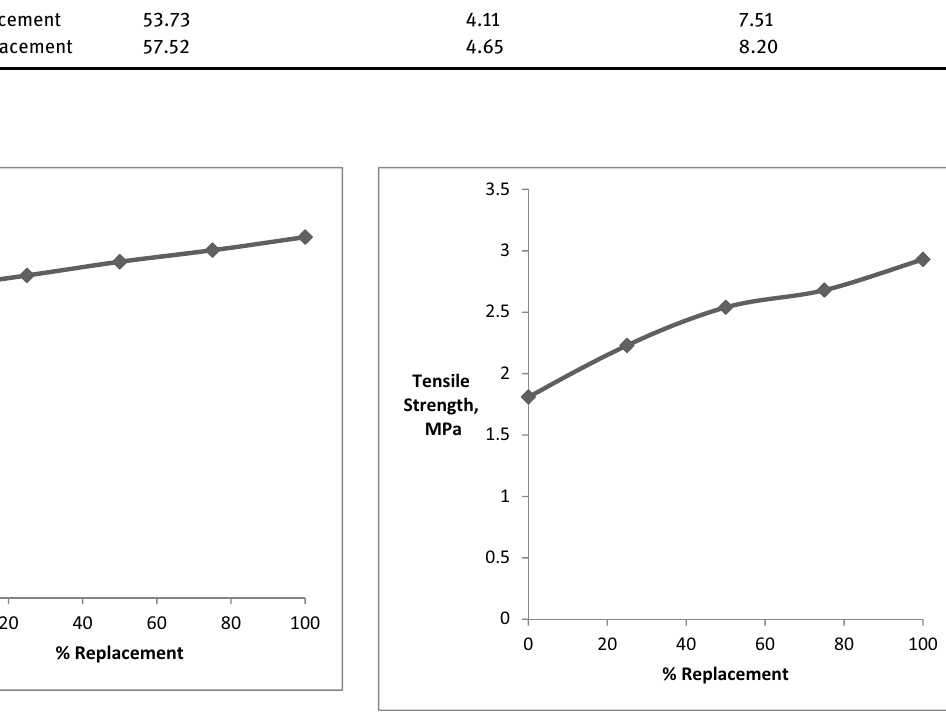
Figure 4: Relation between % replacement and compressive strength of concrete without using superplasticizer.